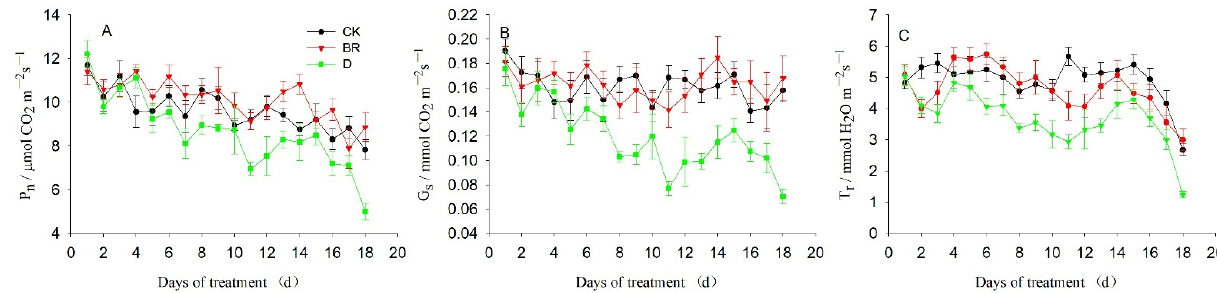
Figure 1. Variations of ( A ) net photosynthetic rate (P n ), ( B ) stomatal conductance (G s ) and ( C ) transpiration rate (T r ) under control (CK), drought stress with 24-epibrassionlide (BR) pre-treatment, and without (D) BR pre-treatment. Values represent the means ± SE ( n =10).